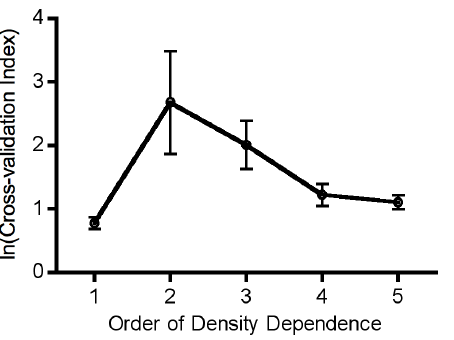
Figure 2. Relative cross-validation scores for models of different orders (lags) of density dependence applied to the 16 empirical time series. Analysis based on a nonparametric test for the order of density dependence [34]. Lower cross-validation scores indicate higher support.